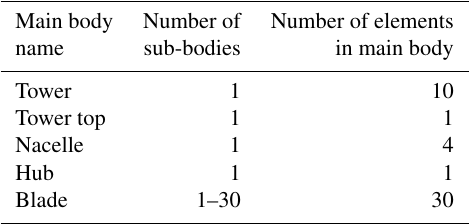
Table 1. General properties of the reference wind turbines: DTU10MW and IEA10MW.